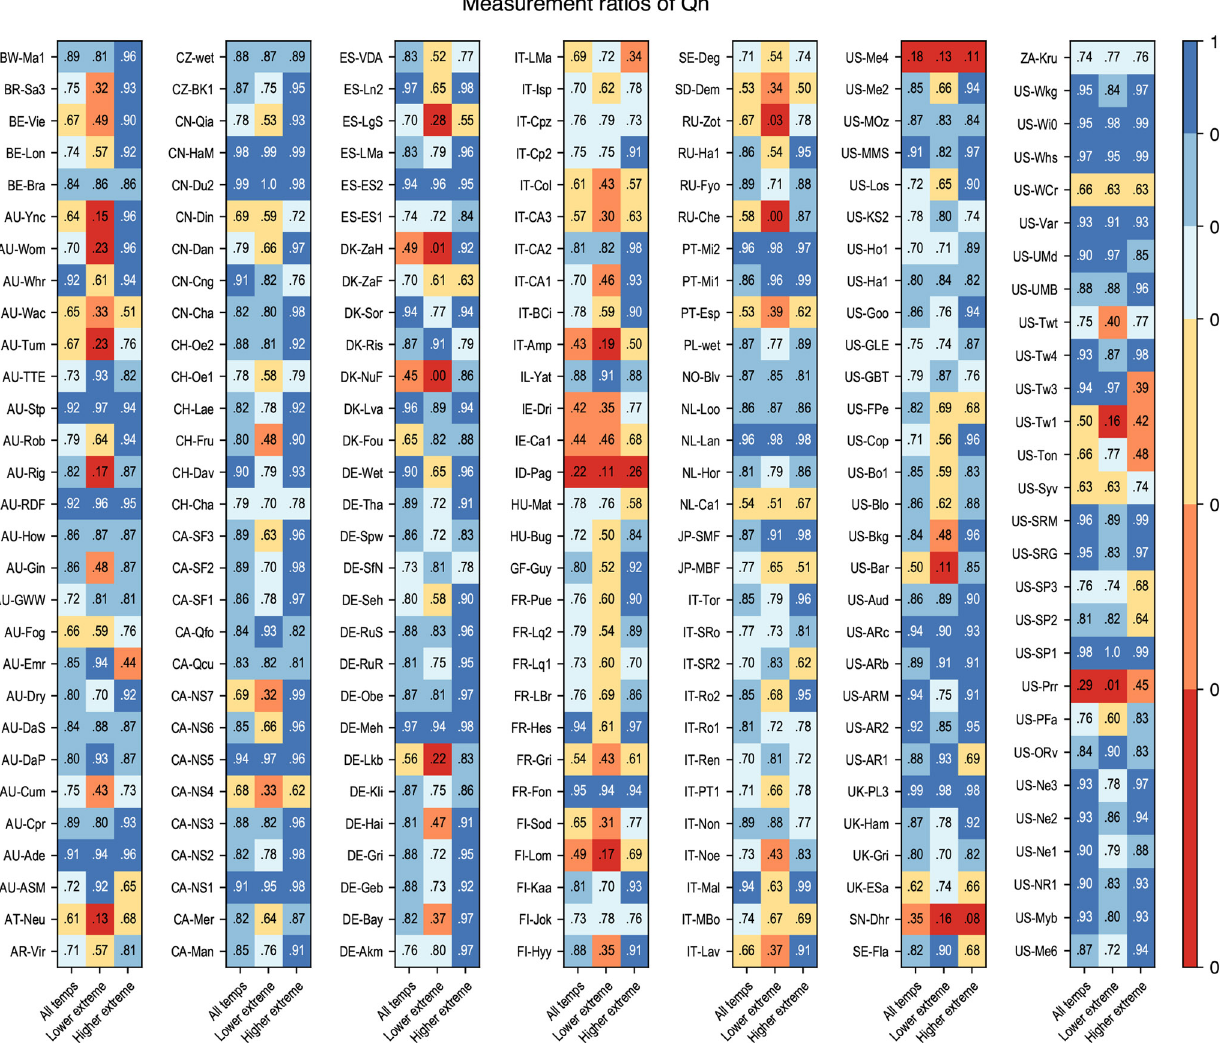
Figure 7. Q h measurement ratios of flux tower sites for all temperatures, the lower extreme temperatures and the upper extreme